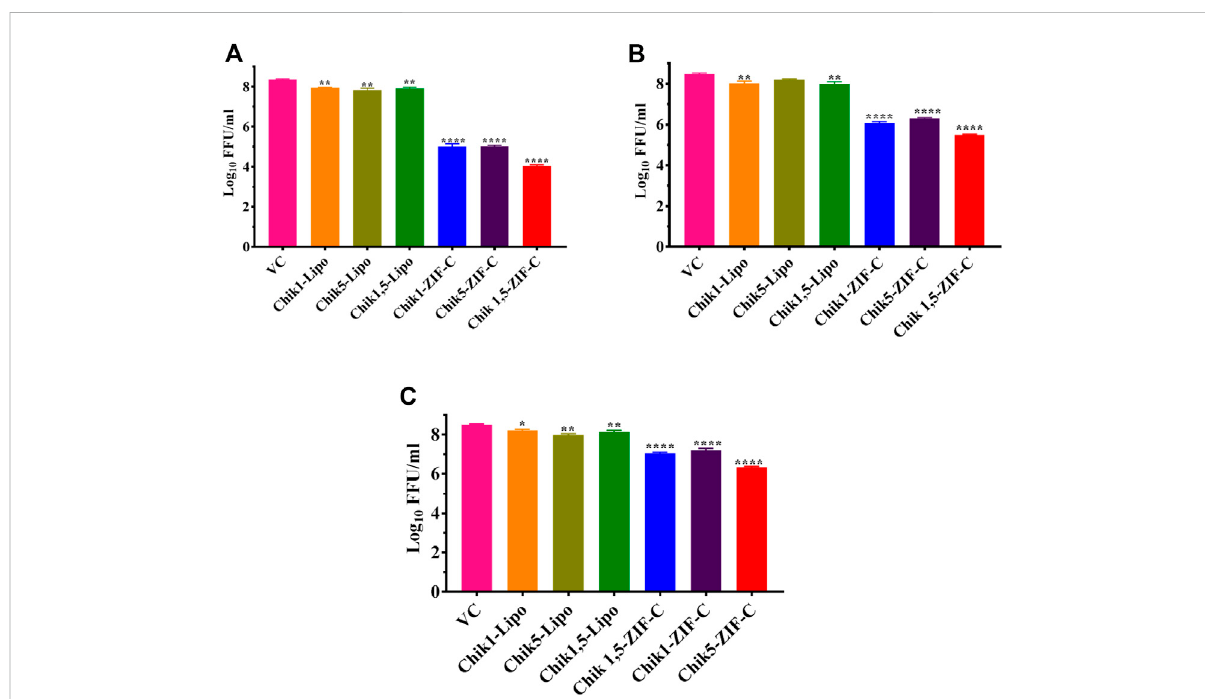
FIGURE 4 TimeofadditiondependentinhibitoryeffectsofsiRNA-ZIF-CandlipofectaminemediateddeliveryofsiRNAontheproductionofvirusparticles. Vero CCL-81 cells were treated with the ZIF-C MOF siRNA formulations (Chik1-ZIF-C, Chik5-ZIF-C and Chik1,5-ZIF-C) and lipofectamine 2000 siRNA complexes (Chik1-Lipo, Chik5-Lipo, and Chik1,5-Lipo) at 0 (A) , 3 (B) and 6 (C) h.p.i. Irrespective of time of addition, the treatment was provided for 6 hours followed by replacement w th fresh MEM containing 2% FBS. The cells were incubated for 24 h post infection. Then the plateswerefrozenandlaterthawedtocollectthecellculturesupernatanttoperformtheFFUassay.Theexperimentswereperformedintriplicatesin three independent trials. All the values are expressed as mean ± SEM. The FFU titres were compared between VC and different siRNA formulations using one-way ANOVA with multiple corrections (**** p < 0.0001, *** p < 0.001, ** p < 0.01, * p <